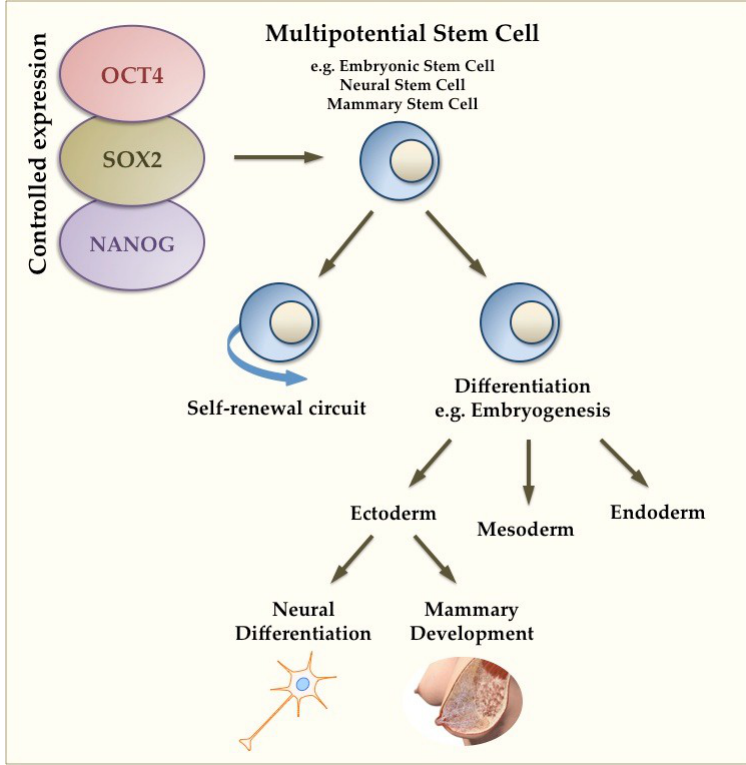
Figure 1. Controlled expression of pluripotency genes in multipotential stem cells. Tight regulation of pluripotency genes OCT4 , SOX2 and NANOG controls the balance between self-renewal and differentiation. Multipotential stem cells are present during embryonic stages and control the formation of the three germ layers: ectoderm, mesoderm and endoderm. The mammary gland picture is reproduced with permission from Medela